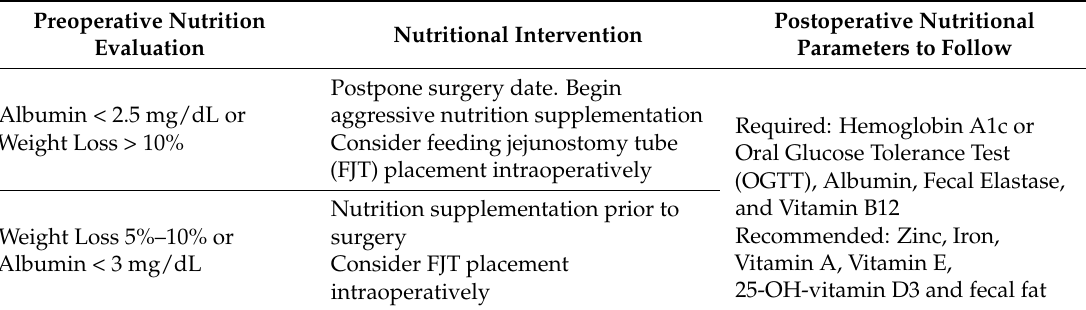
Table 1. Perioperative Nutritional